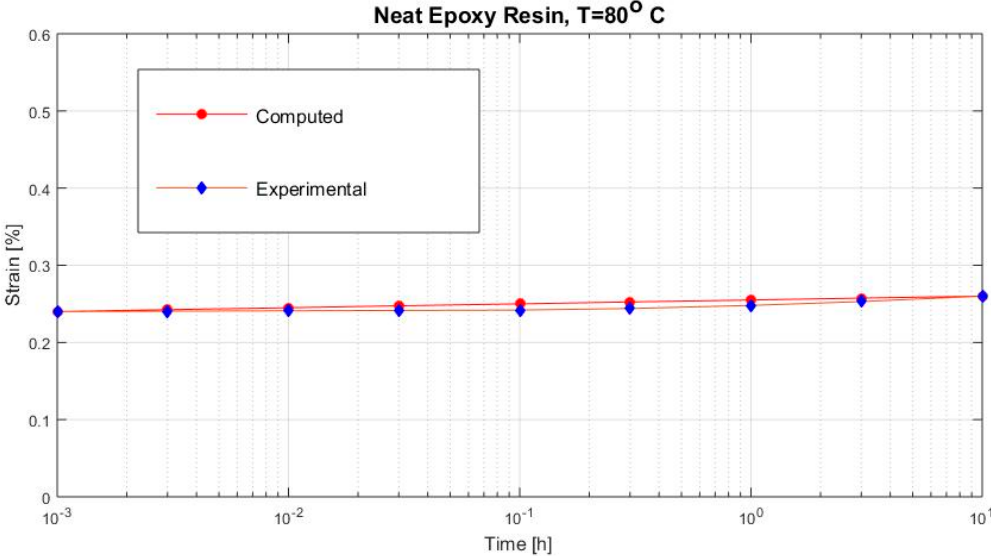
= σ 26 MPa at 23 22